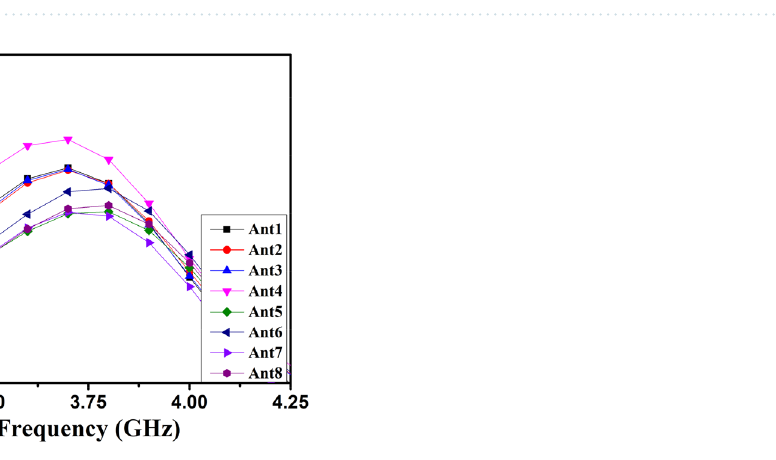
Figure 31. Hand effect on the mobile framed-based MIMO (M-shaped) antenna simulated total